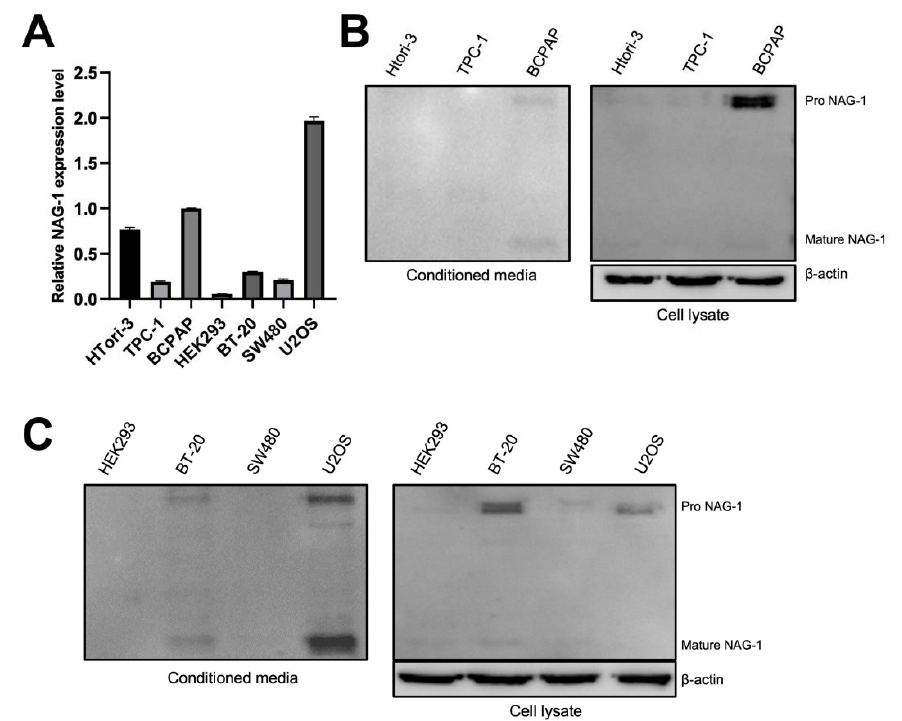
Figure 2. NAG-1 expression in various types of cancer cell lines. ( A ) Quantitative reverse transcriptase-polymerase chain reaction (RT-qPCR) was conducted using both thyroid (HTori-3, TPC-1, and BCPAP) and non-thyroid cell lines (HEK-293, BT-20, SW480, and U2OS). Analysis was performed in triplicate, and the graph shows the mRNA levels of NAG-1 expression compared with those of BCPAP cells. Western blot analysis using ( B ) thyroid and ( C ) non-thyroid cancer cells. Conditioned medium and total cell lysates were isolated as described in the Methods section, and NAG-1 antibodies against pro- and mature NAG-1 were hybridized into the membrane. Uncropped versions of blots presented in the Figure S4 and Figure S5.